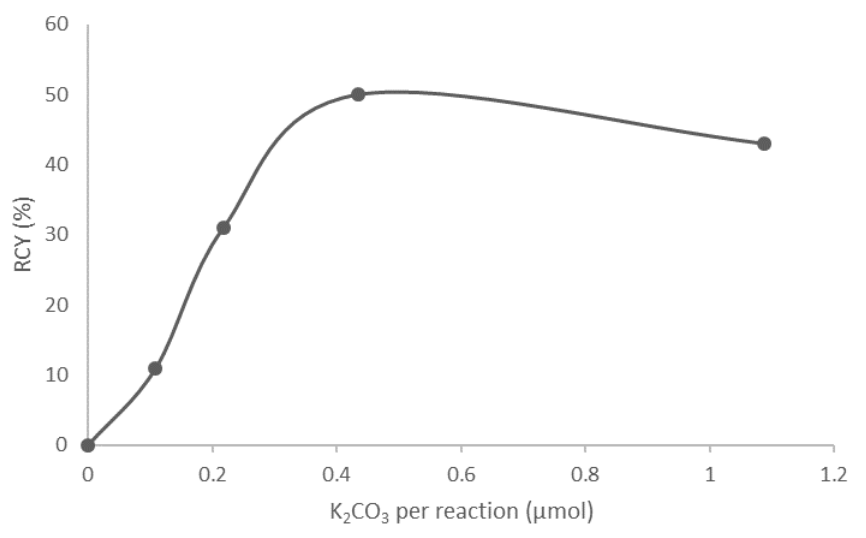
Figure 1. Effect of a variable amount of K 2 CO 3 on RCC.